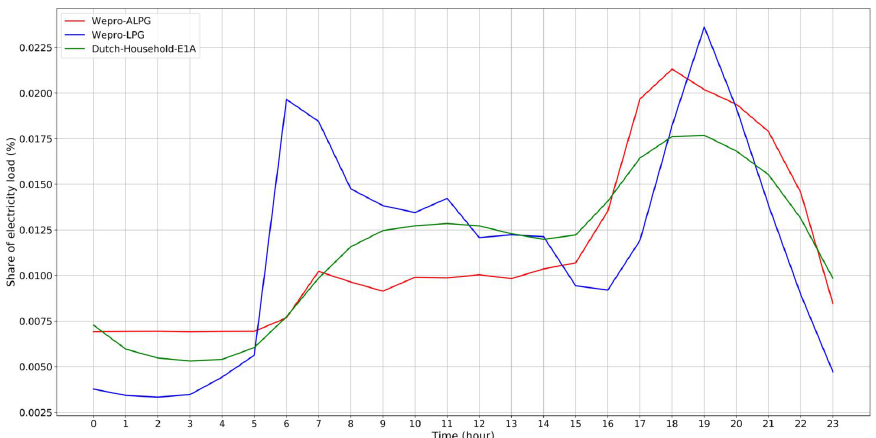
Figure 14. The comparison of hourly average standard residential load profile in The Netherlands based on NEDU ’s data of 2016, E1A and the hourly average load profile in a year of Wepro-LPG and Wepro-ALPG.